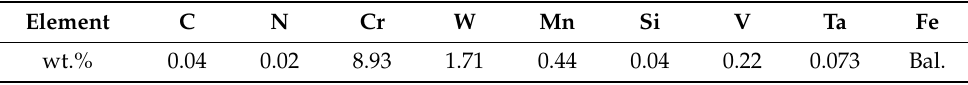
Table 1. Chemical composition of 9Cr martensitic/ferritic heat-resistant steel in wt.%. Element